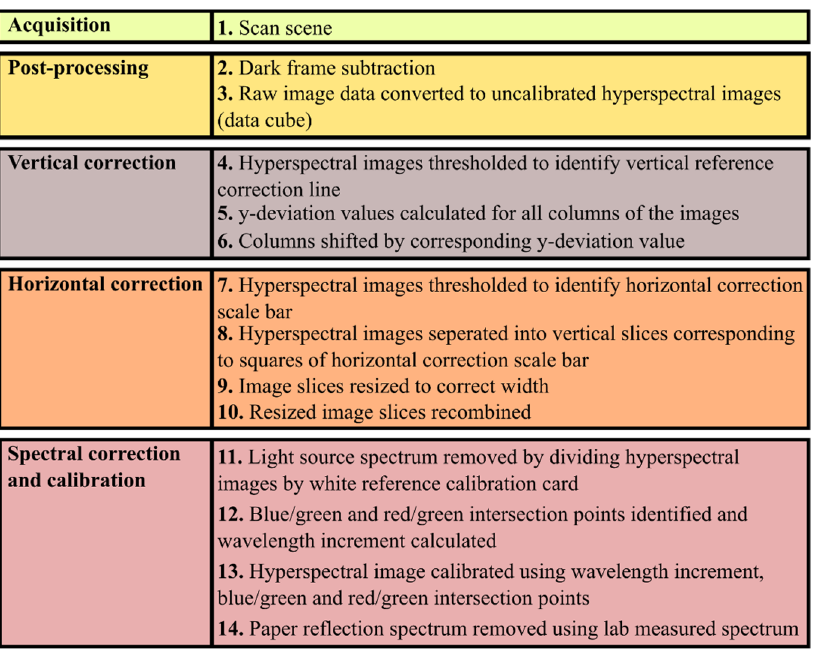
Figure 1. Workflow diagram for each stage of the image acquisition, pre-processing, vertical and horizontal correction and spectral correction and calibration.